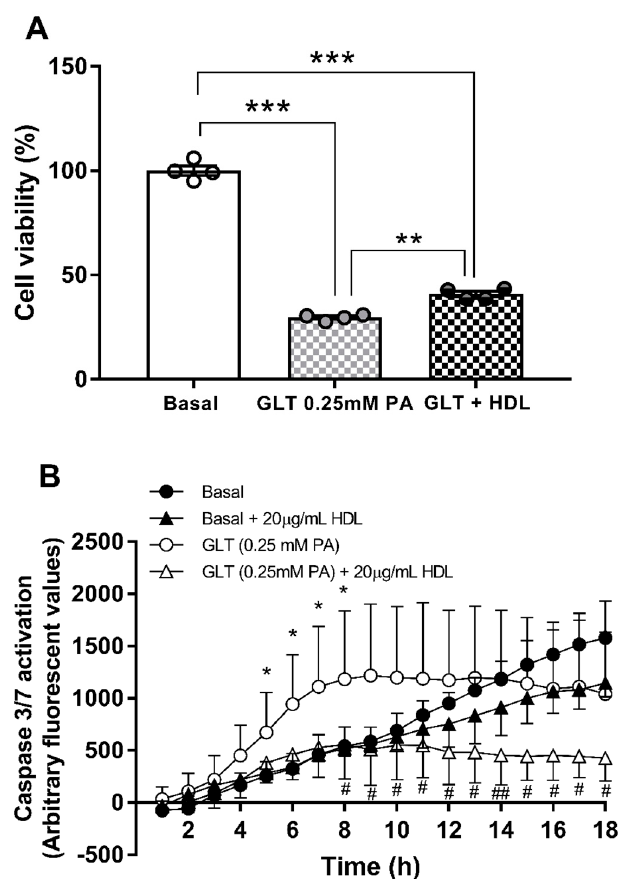
Figure 3. The effect of HDL (20 µ g mL − 1 ) on cell viability, tested by resorufin conversion, under GLT challenge (0.25 mM PA and 30mM) glucose is shown in ( A ); results are the mean ± SEM of 4 independent experiments, analysed by one-way ANOVA with post hoc (Dunnett’s) test for the comparisons indicated: ** p < 0.01 and *** p < 0.001. The ability of the same concentration of HDL to protect against GLT-induced apoptosis in 1.1B4 cells, measured by caspase3/7 activation, is shown in ( B ); values are the mean ± SEM of 4 independent replicates in a single experiment. Statistical analysis was performed using repeated measures ANOVA with post hoc (Dunnett’s) test compared to the basal condition; * p < 0.05 and compared to GLT challenge alone: # p < 0.05 and ## p < 0.01 compared at the time points indicated.